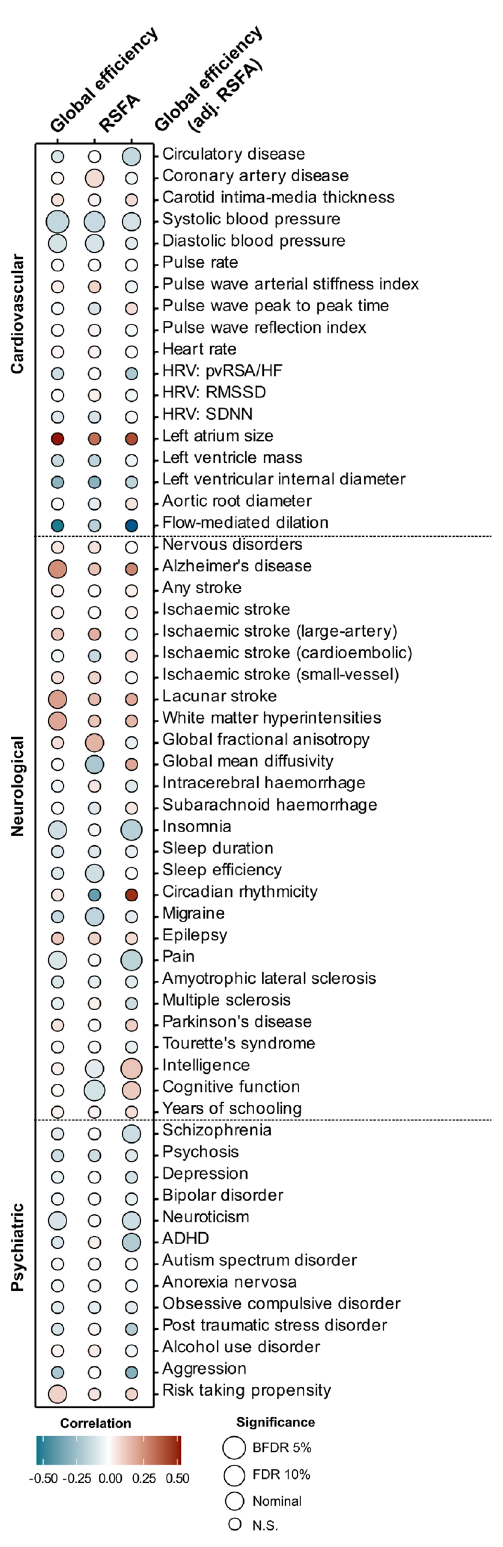
Figure 4. Bubbleplot for genetic correlations between global efficiency, resting state fluctuation amplitudes (RSFA) and global efficiency adjusted for RSFA and 58 cardiovascular, neurological and psychiatric traits. RSFA, resting state fluctuation amplitudes; HRV, heart rate variability; ADHD, attention deficit hyperactivity disorder; FDR, false-discovery rate; N.S.,